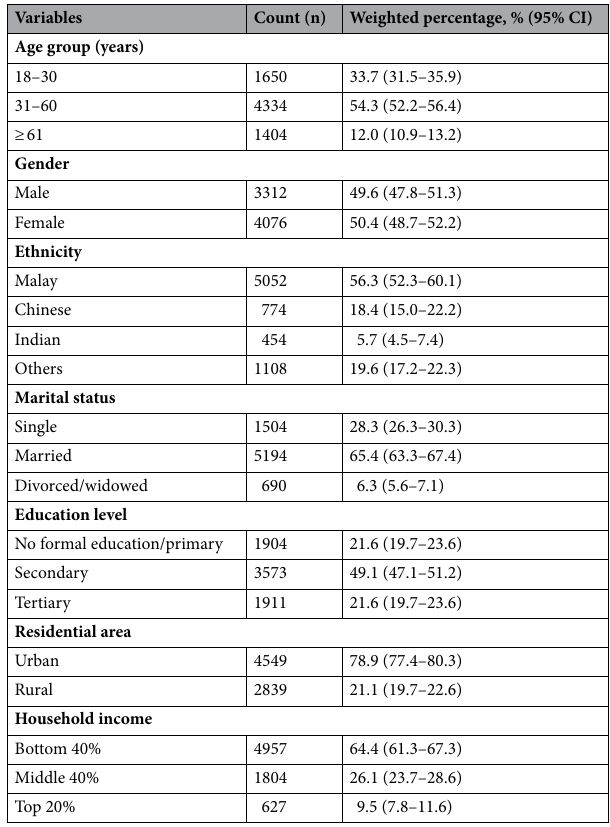
Table 1. Socio-demographic characteristics of the study population (n =